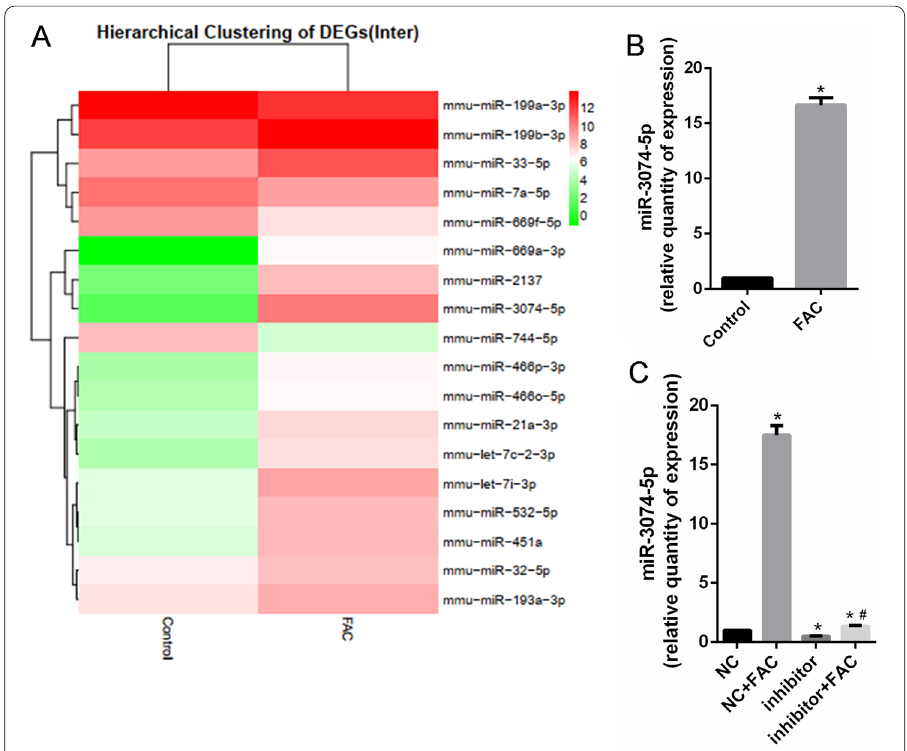
Fig. 2 miR‑3074‑5p expression was increased in MC3T3‑E1 cells under iron overload conditions. A Heatmap of 18 miRNAs displaying significant upregulation (red pixels) or downregulation (green pixels) in MC3T3‑E1 cells treated with 1.8 mM FAC, compared with the control. B , C miR‑3074‑5p expression was validated by qRT‑PCR. Inhibitor indicated miR‑3074‑5p inhibitor. NC indicates the negative control. * P < 0.05 vs. the NC group. # P < 0.05 vs. the NC FAC +